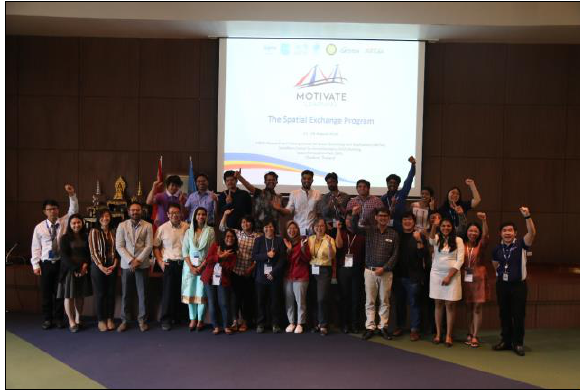
Figure 6. The participants of the Spatial Exchage Programme under MOTIVATE